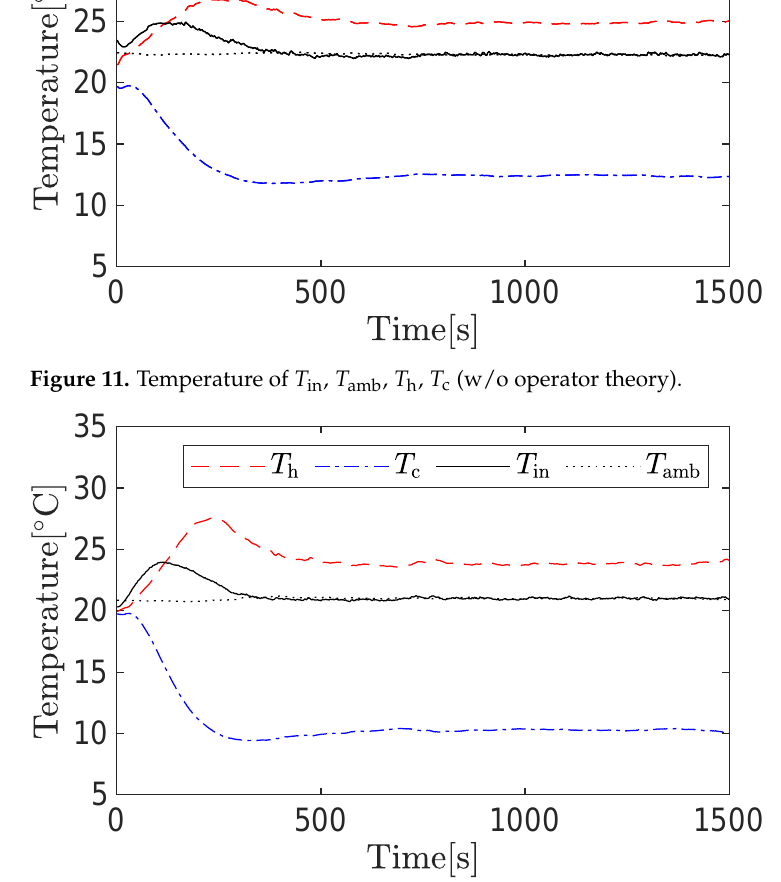
Figure 12. Temperature of T in , T amb , T h , T c (w/ operator theory).